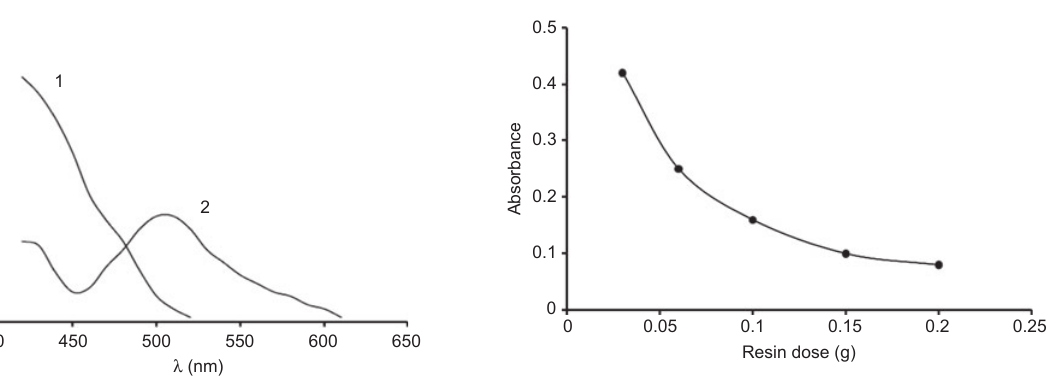
Figure 3 Color development vs. the NRS-Dowex 1 × 1 resin amount: 1 mg/l Rh 3 + , pH =